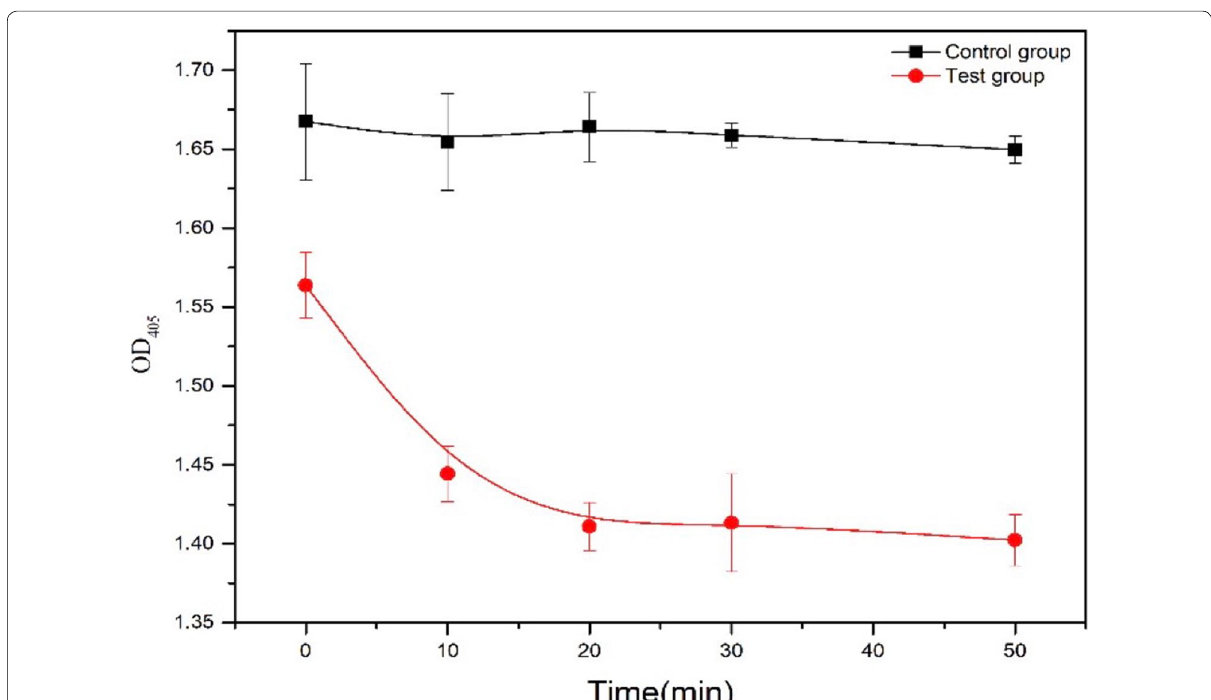
Fig. 4 GSH changes with time between control and test group after optimizing the LigF reaction system. In this part, the total volume of reaction mixture was 5 mL. The test group including 300 μL 20 mM GVG, 200 μL 3 mg/mL GSH, 3800 μL 50 mM Tris–Cl (pH 8.0), 700 μL cell lysate containing the protein of 0.5 mg/mL. While in the control group, the cell lysate was replaced by 700 μL 50 mM Tris–Cl buffer (pH 8.0). The reaction was carried out at 27 °C and 80 rpm. And then the equal volume of ethyl acetate was added to the reaction mixture to stop the enzymatic reaction. The mixture was centrifuged for 2 min at 13000 rpm and 50 μL water phase was taken for the GSH content analysis to describe the LigF activity